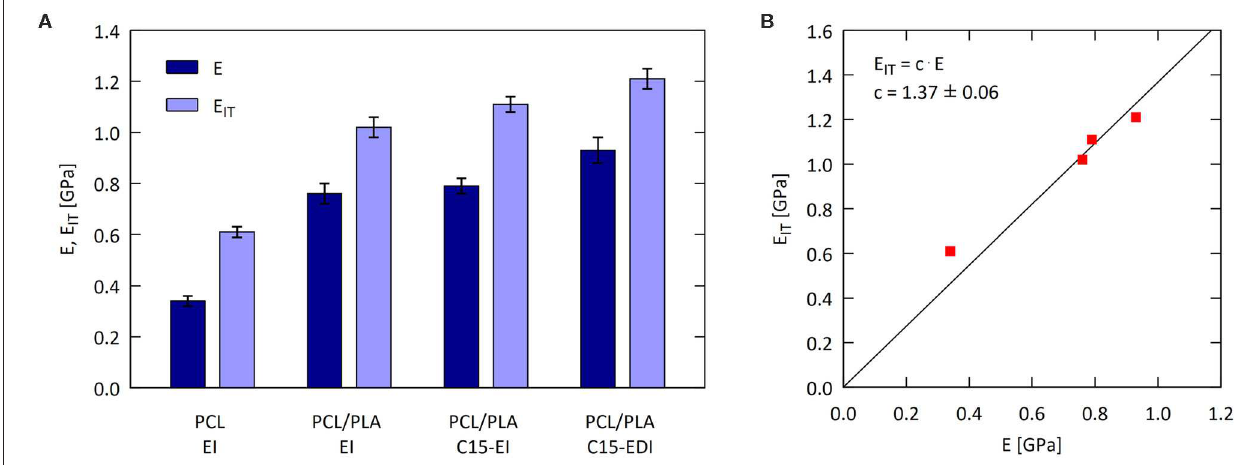
FIGURE 6 | Elastic modulus of the injection molded specimens: (A) comparison of macroscopic tensile modulus ( E ) with microscopic indentation modulus ( E IT ) and (B) correlation E - E IT .